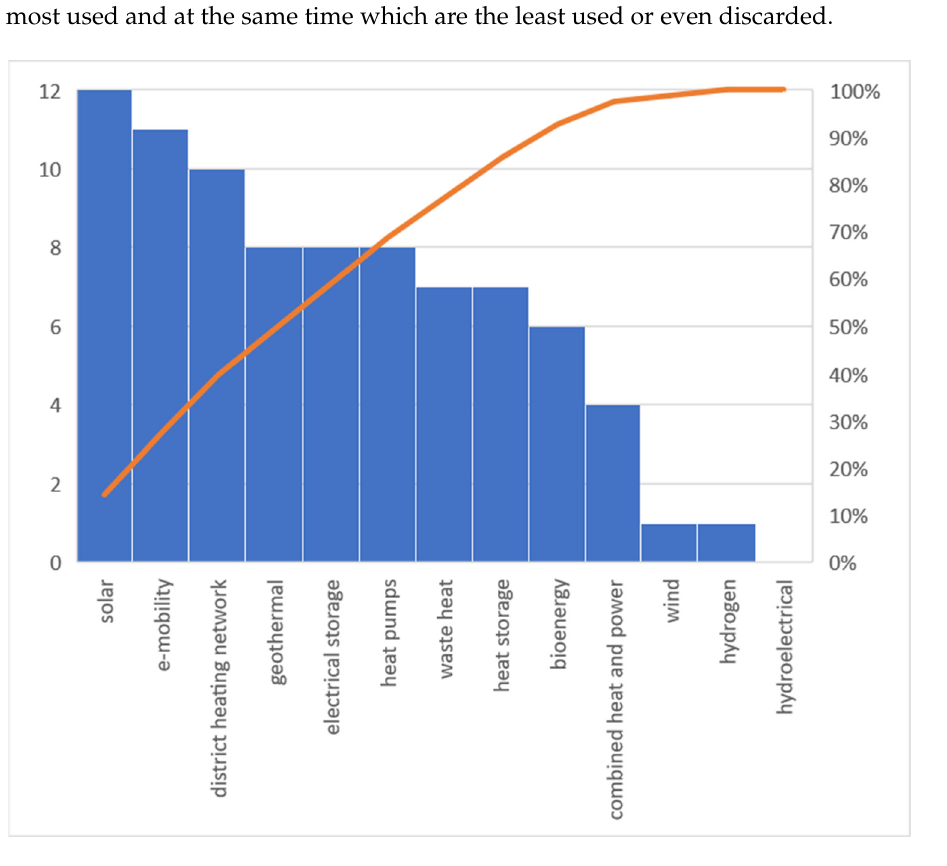
Figure 9. Number of technology selections with reference to the total number of case studies.